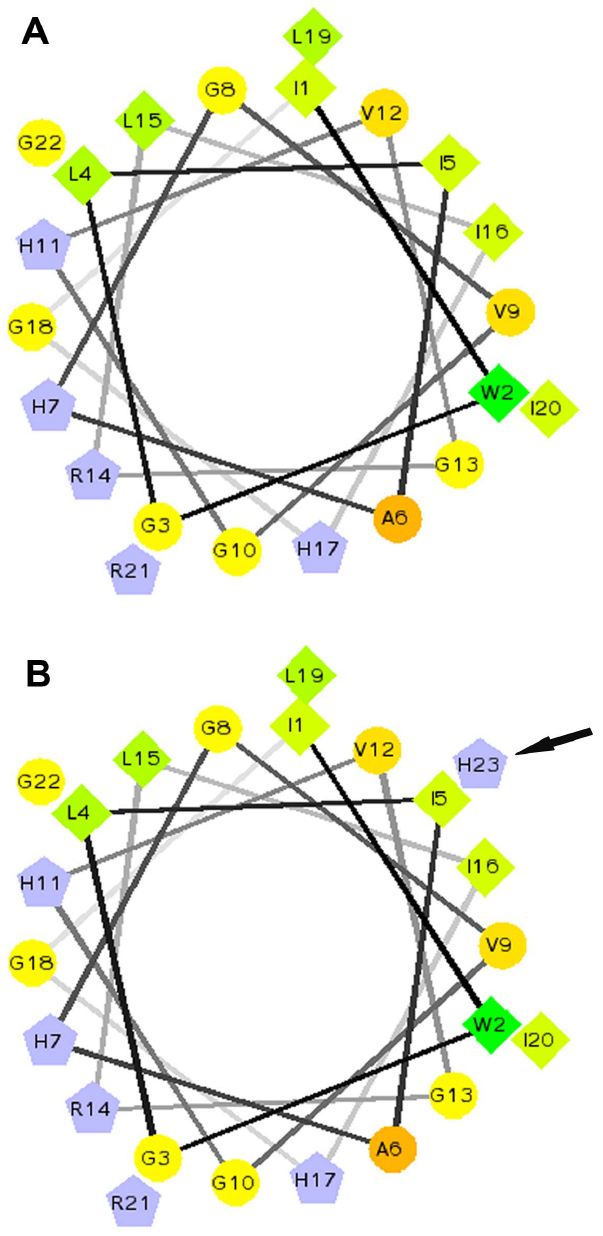
Figure 1. The Schiffer-Edmundson helical wheel diagrams of Pc-pis (A) and Pc-pis-His (B). The amino acid residues are consecutively numbered starting from the N-terminal of the mature peptides, with lines connecting each consecutive amino acid in the sequence. Pentagons and diamonds represent hydrophilic charged and hydrophobic residues, respectively. The circles denote other neutral or polar amino acids. The arrow shows the predicted position of the added histidine residue is in the middle of the hydrophobic phase. Picture A comes from [1].